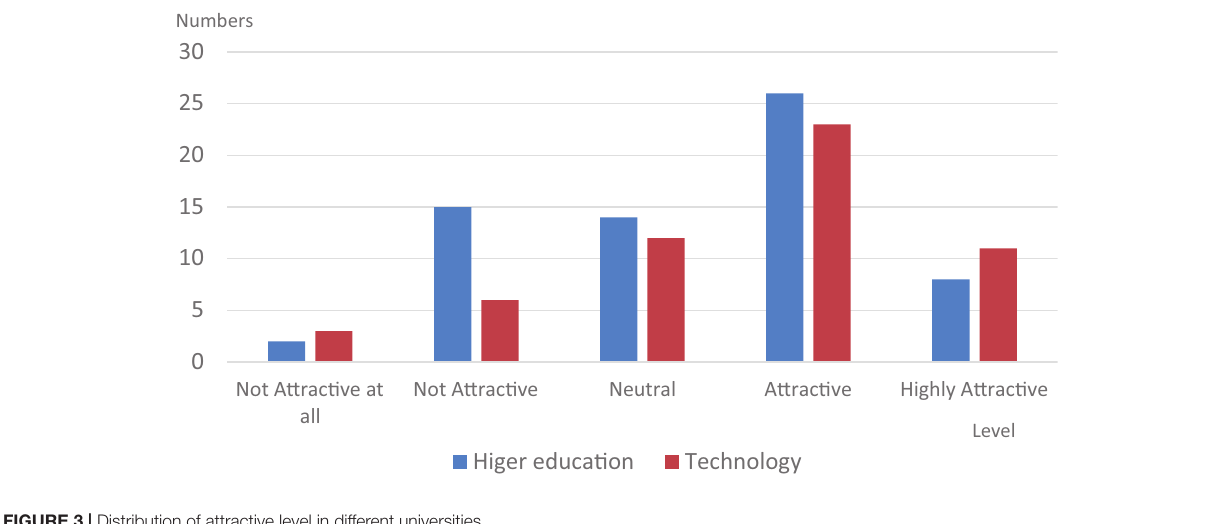
and changes in healthcare organizations. These differences